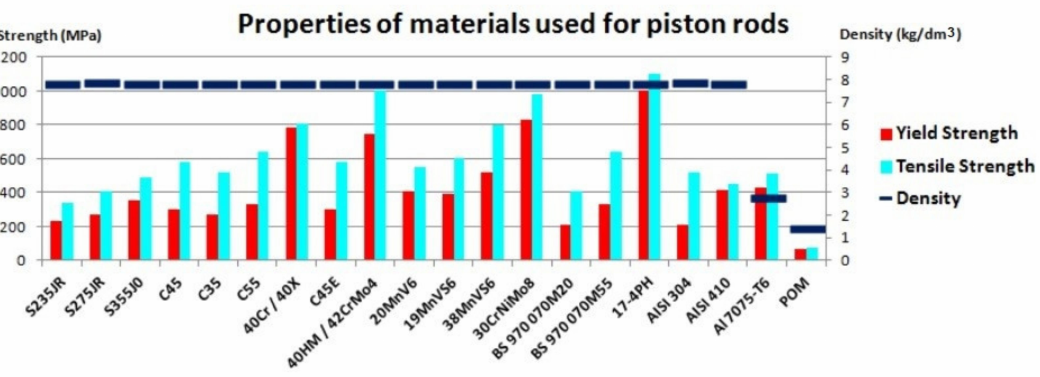
Figure 8. Chart of properties of the materials used for the piston rods. Table 5. Basic properties of the materials used for piston